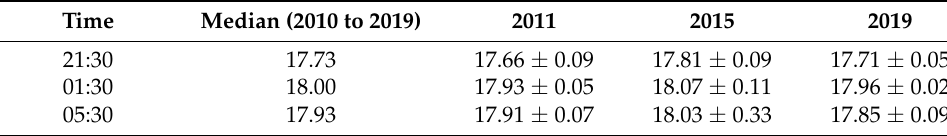
Table 4. Binned Winter Evolution in Johnson V (mag/arcsec 2 ).